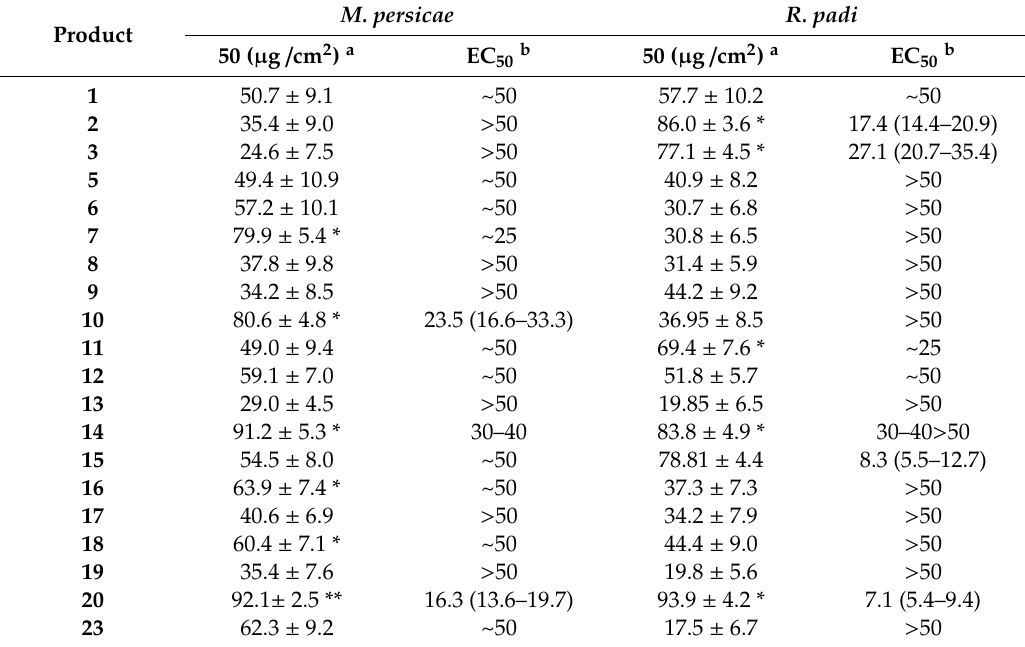
Table 2. Insect antifeedant e ff ects of nootkatone ( 1 ) and derivatives 2 – 23 against aphids. M. persicae R. Product